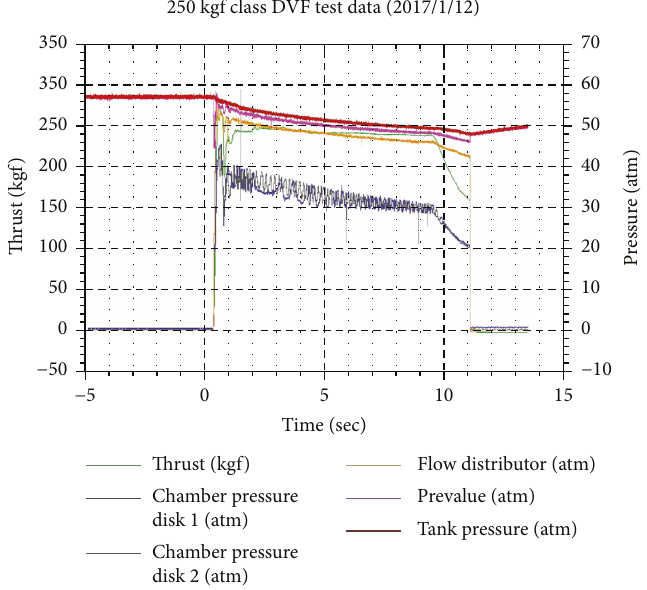
Figure 14: Measured data (thrust and pressures) of 250 kgf class DVF engine during the hot- fi re test.